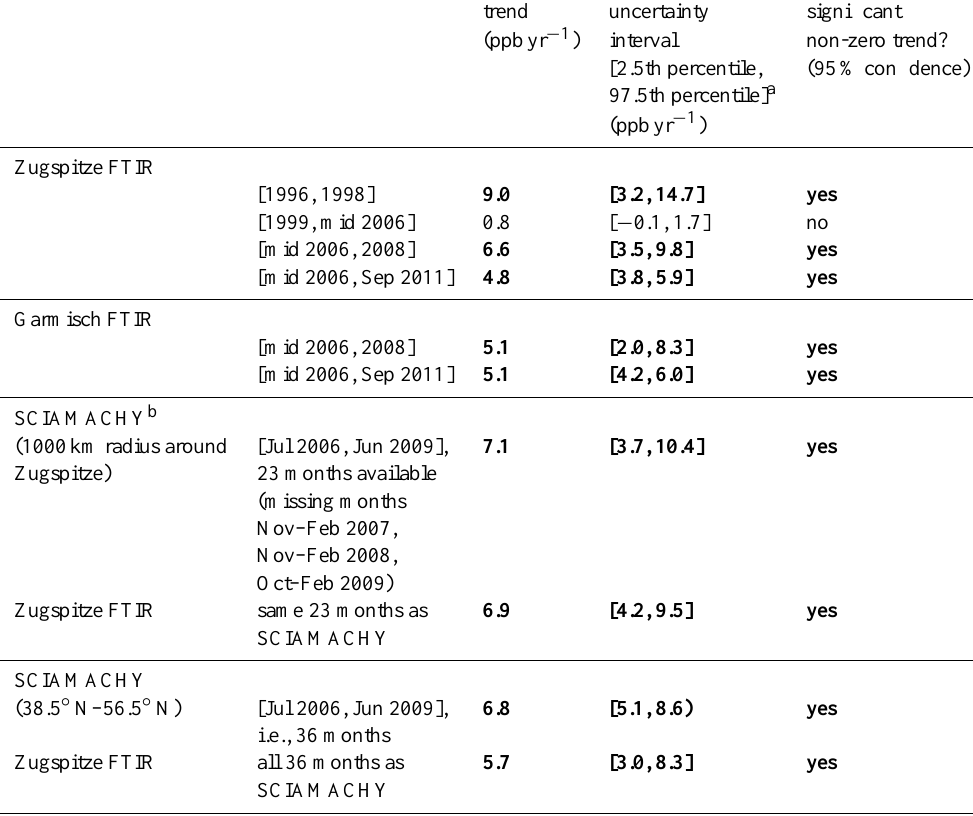
Table 2. Existence and significance of trends of column-averaged mole fractions of CH 4 .